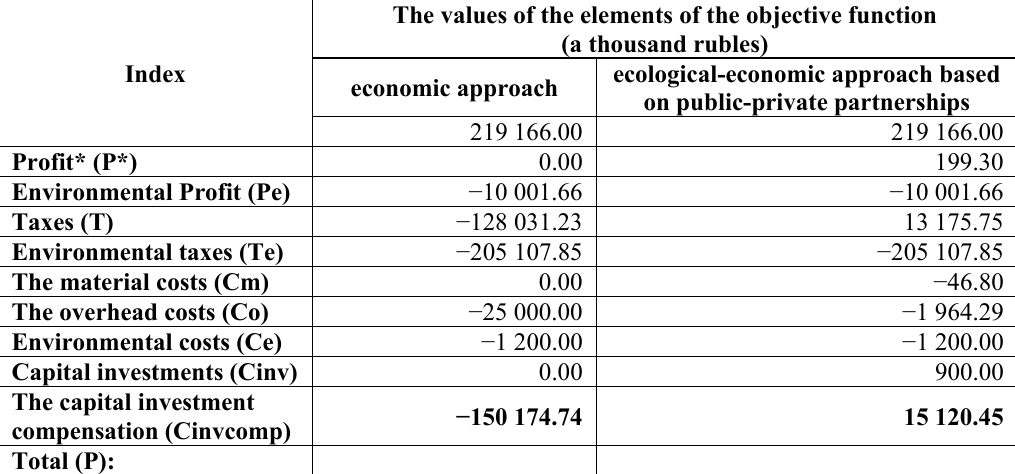
Table 2. The Initial Data for the Calculation of the Value of the